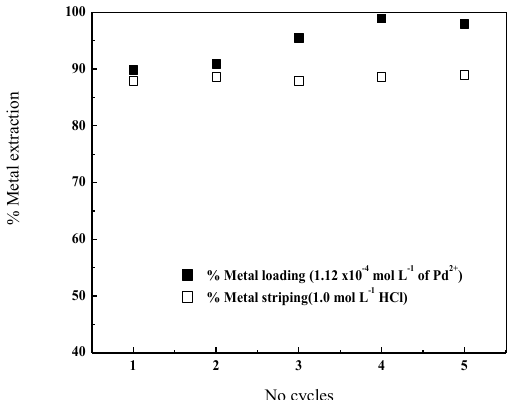
Figure 6. Loading and striping studies of Pd(II) with HPBI. Conditions for extraction = 1.12 × 10 -4 mol L -1 Pd(II) in 0.05 mol L -1 H + at 1.0 mol L -1 Cl - , 1.0 × 10 -3 mol L -1 HPBI in CHCl ; Conditions for desorption = 1.0 mol L -1 3